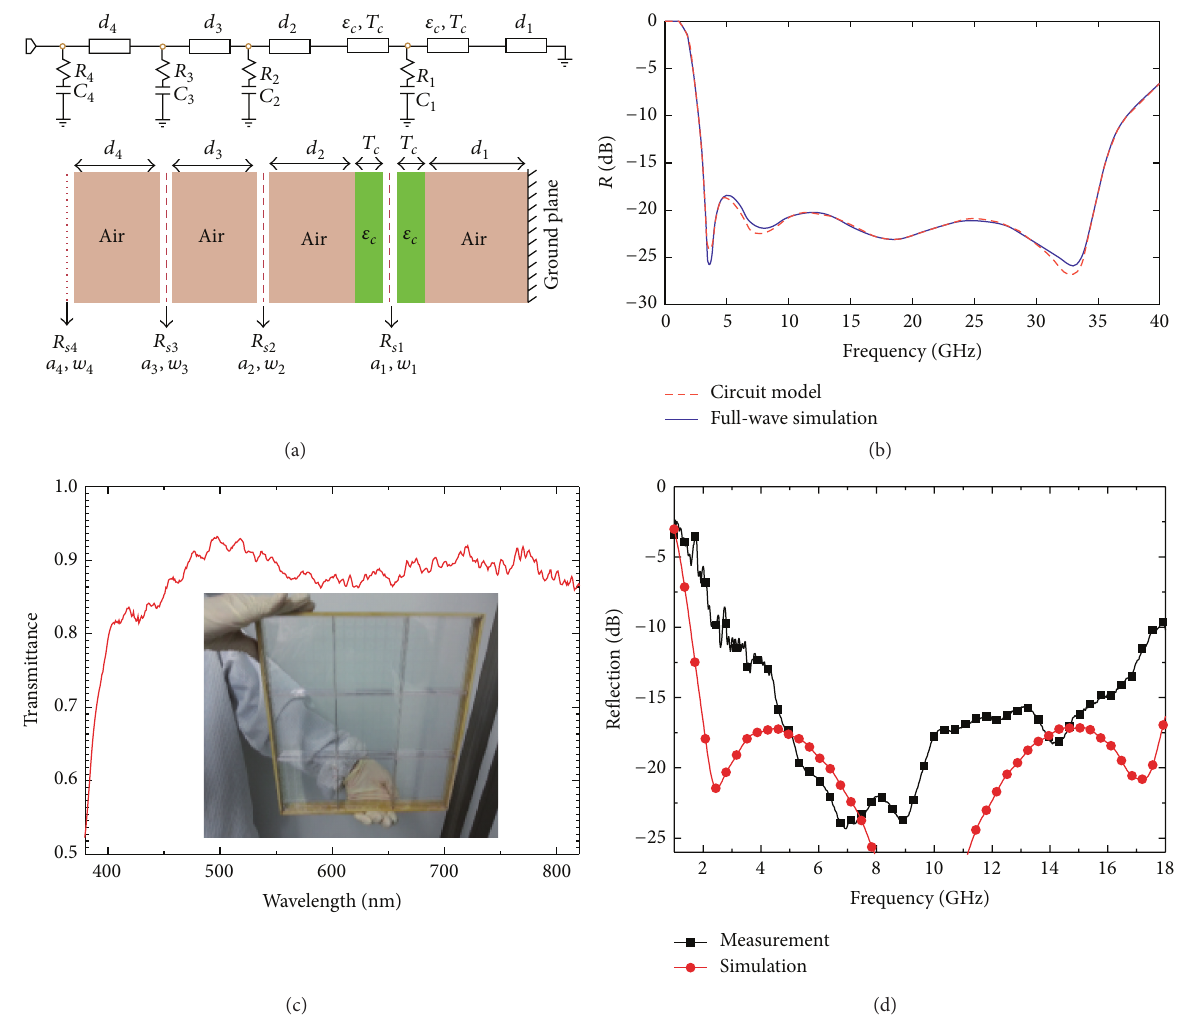
Figure 18: (a) The schematic of the ultrawideband absorber with optimal thickness. Top: the equivalent circuit model. Bottom: the actual realization of the absorber. The resistive layers are periodic square patches with periodicity ( 𝑎 ), width ( 𝑤 ), and sheet resistivity ( 𝑅 𝑠 ). (b) The frequency response of the reflection coefficient for the ultrawideband absorber with optimal thickness obtained from both the equivalent circuit model and the full-wave simulation. (c) Optical transmittance for the optical-transparent absorber. Inset shows the photograph. (d) Microwave absorption for both the experiment and the full-wave simulation. Figures are reproduced from (a, b) [110] and (c, d)